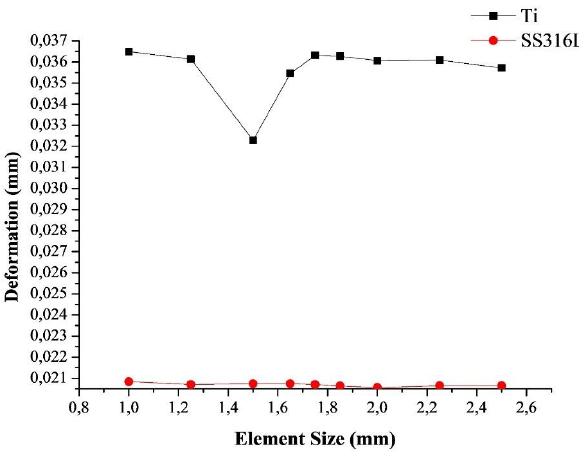
Figure 7: Graph of relationship between element size and deforma- tion (mm) Ti-6Al-4V and SS 316 L